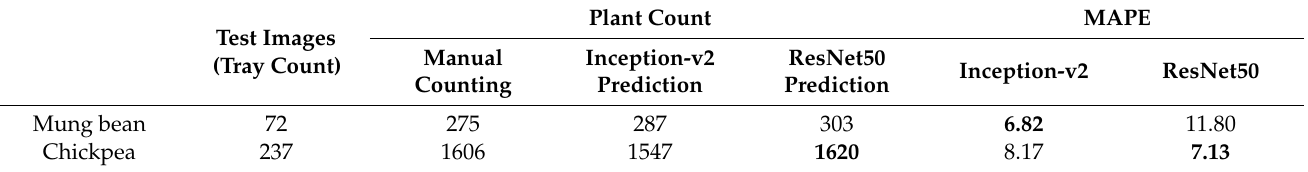
Table 2. Ground truth (manually counted) plant counts predicted plant counts and MAPE values for the mung bean and chickpea datasets.